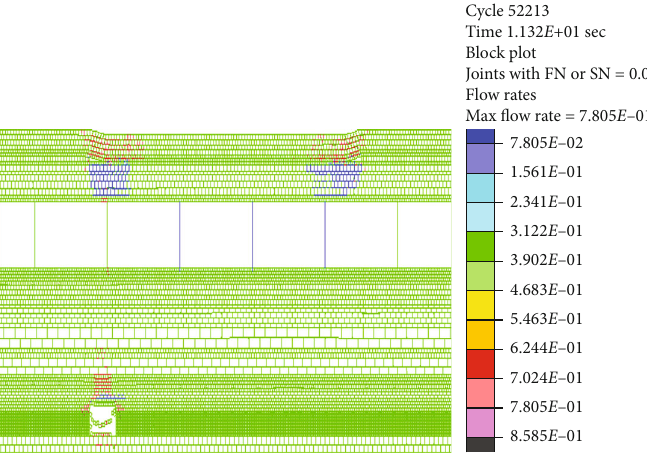
Figure 4: The fl ow distribution in initial caving of direct